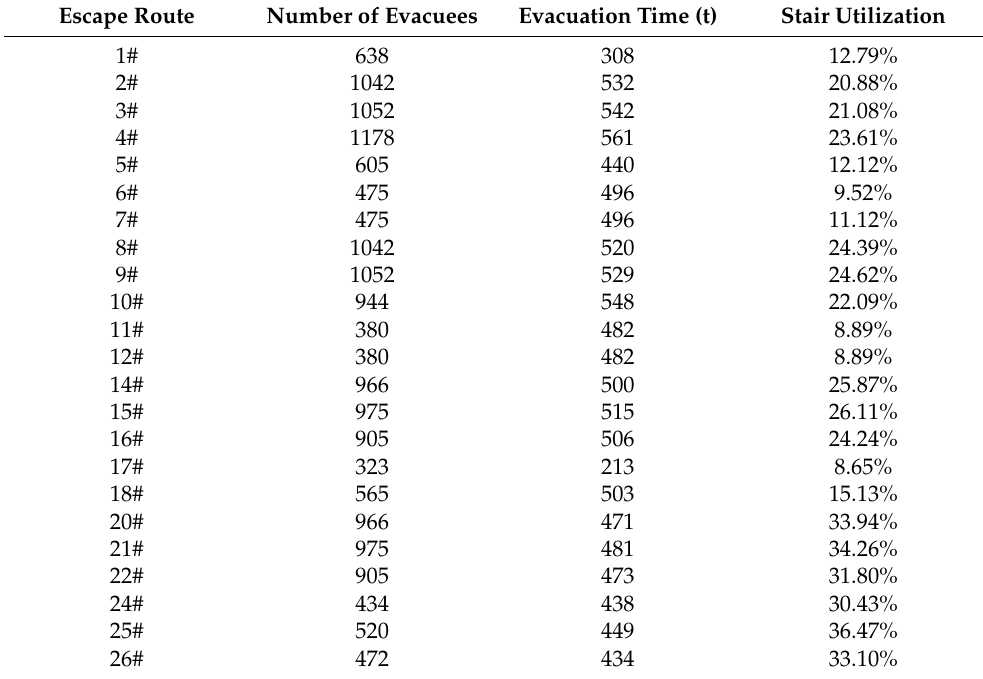
Table 5. Evacuation time and number of evacuees after optimization. Escape Route Number of Evacuees Evacuation Time (t)